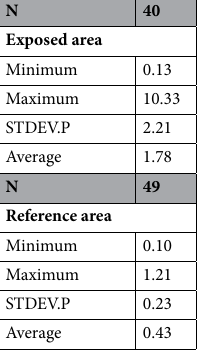
Table 1. Summary statistics for arsenic concentrations (μg/g) in fingernail samples. *Normal level of arsenic in nail samples ranges from 20 to 500 μg/kg 22 .